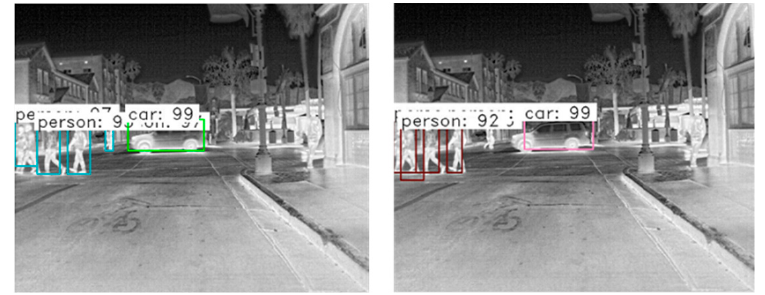
Figure 10. Comparison of target detection results between CMF Net and Faster R-CNN.